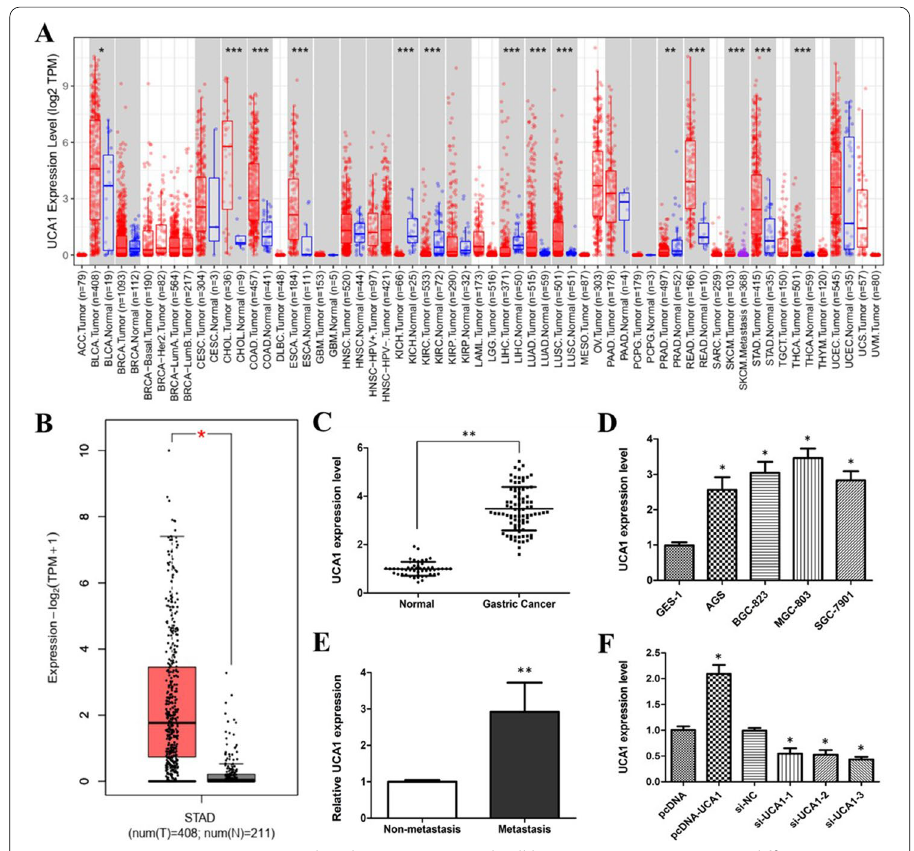
Fig. 2 UCA1 expression was upregulated in GC tissues and cell lines. A UCA1 expression in different cancers was analyzed by TIMER2. B The box plot data about UCA1 expression were supplied from TCGA and GTEx databases. C UCA1 expression level in GC tissues and adjacent normal tissues determined by Q-PCR. D Q-PCR results displaying UCA1 expression level in GC cell lines and human normal gastric epithelium cell line GES-1. E Q-PCR showing UCA1 expression level in non-metastatic and metastatic GC tissues. F UCA1 overexpression or knockdown by transfecting pcDNA3.1-UCA1 or siUCA1. *p < 0.05, **p < 0.01, ***p < 0.001, compared with normal tissues or cell